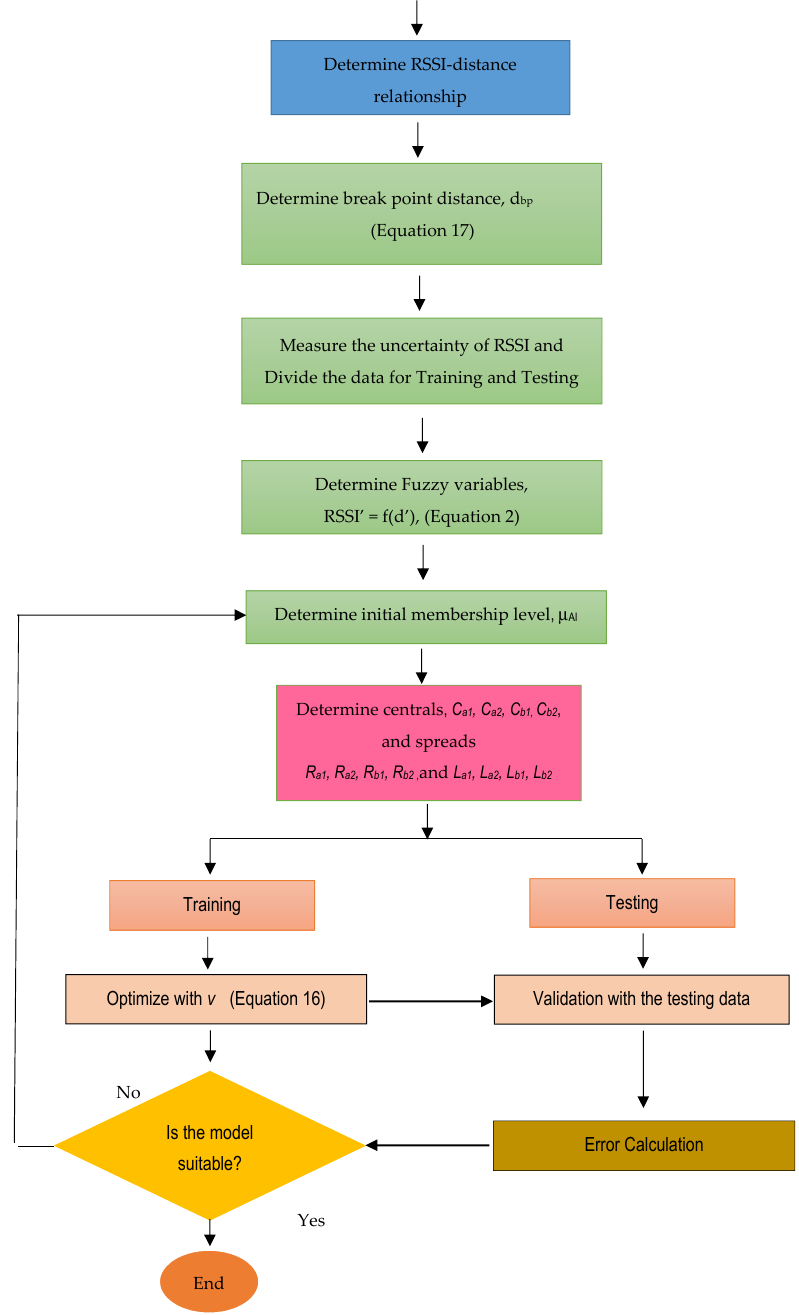
Figure 2. Flow chart of MBFLR